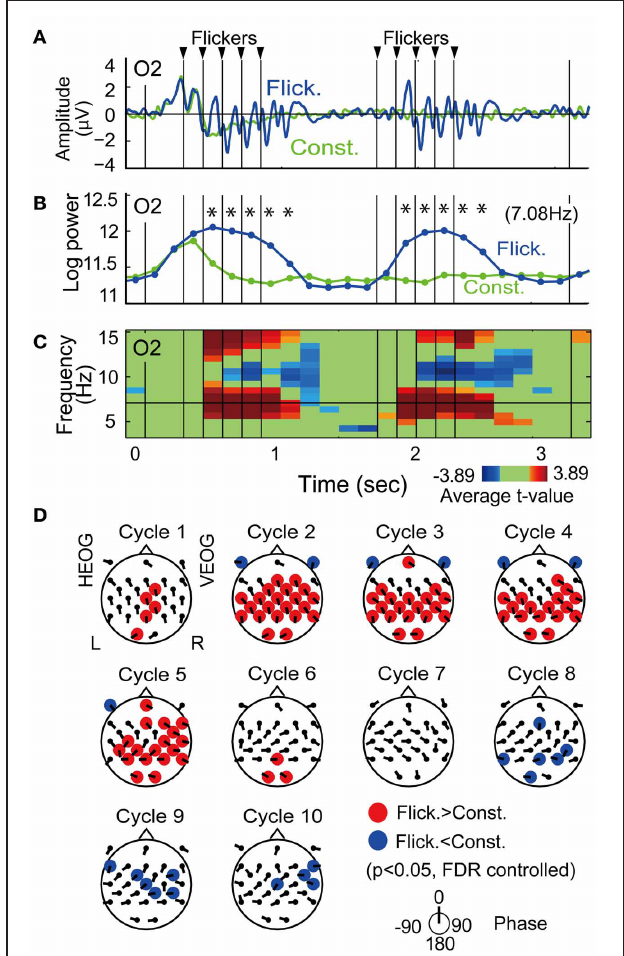
FIGURE 3 | Flicker-induced EEG. (A) Temporal evolution of EEG signal during encoding at an O2 electrode averaged across all participants. Blue and green indicate EEG signals in the Flicker and Constant conditions, respectively. For display purposes, the EEG signals were band-passed between 3 and 20Hz by using a Butterworth filter. Triangles at the upper part of the plot indicate timings of flicker. (B) Temporal evolution of EEG power at the flicker’s frequency. Asterisks indicate significant difference of EEG power in Flicker condition with that in Constant condition ( p < 0 . 05). (C) Time-frequency plot of average t -values comparing EEG power in Flicker condition with that in Constant condition. Red represents significant increase of EEG power and blue represents significant decrease of EEG power. Green represents no significant difference. (D) Topographical maps of average p -value at each cycle showing difference of EEG power in Flicker condition with that in Constant condition. Red represents significant increase of EEG power and blue denotes significant decrease of EEG power ( p < 0 . 05, FDR controlled). Direction of arrow at each electrode location indicates a mean phase of EEG in Flicker condition against the flicker